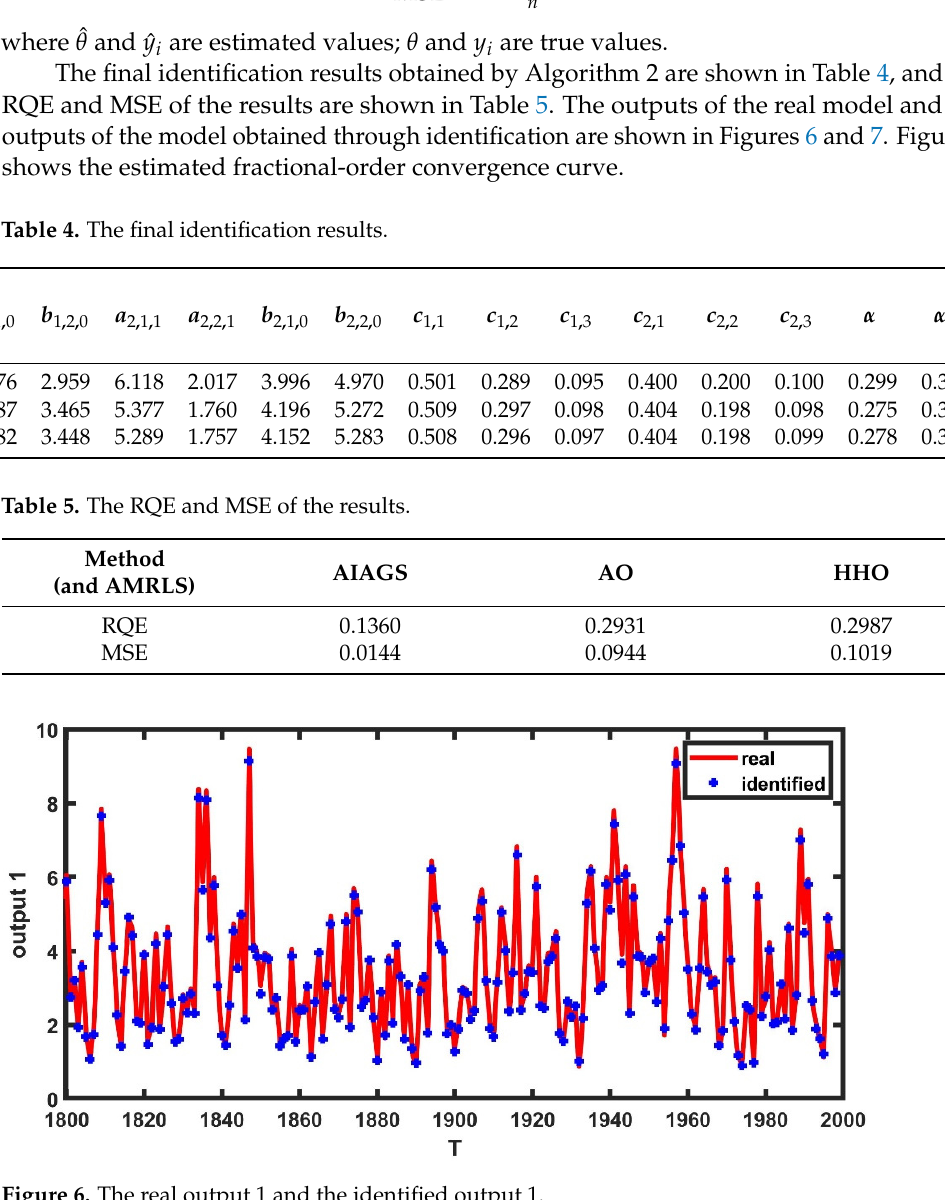
Figure 6. The real output 1 and the identified output 1.